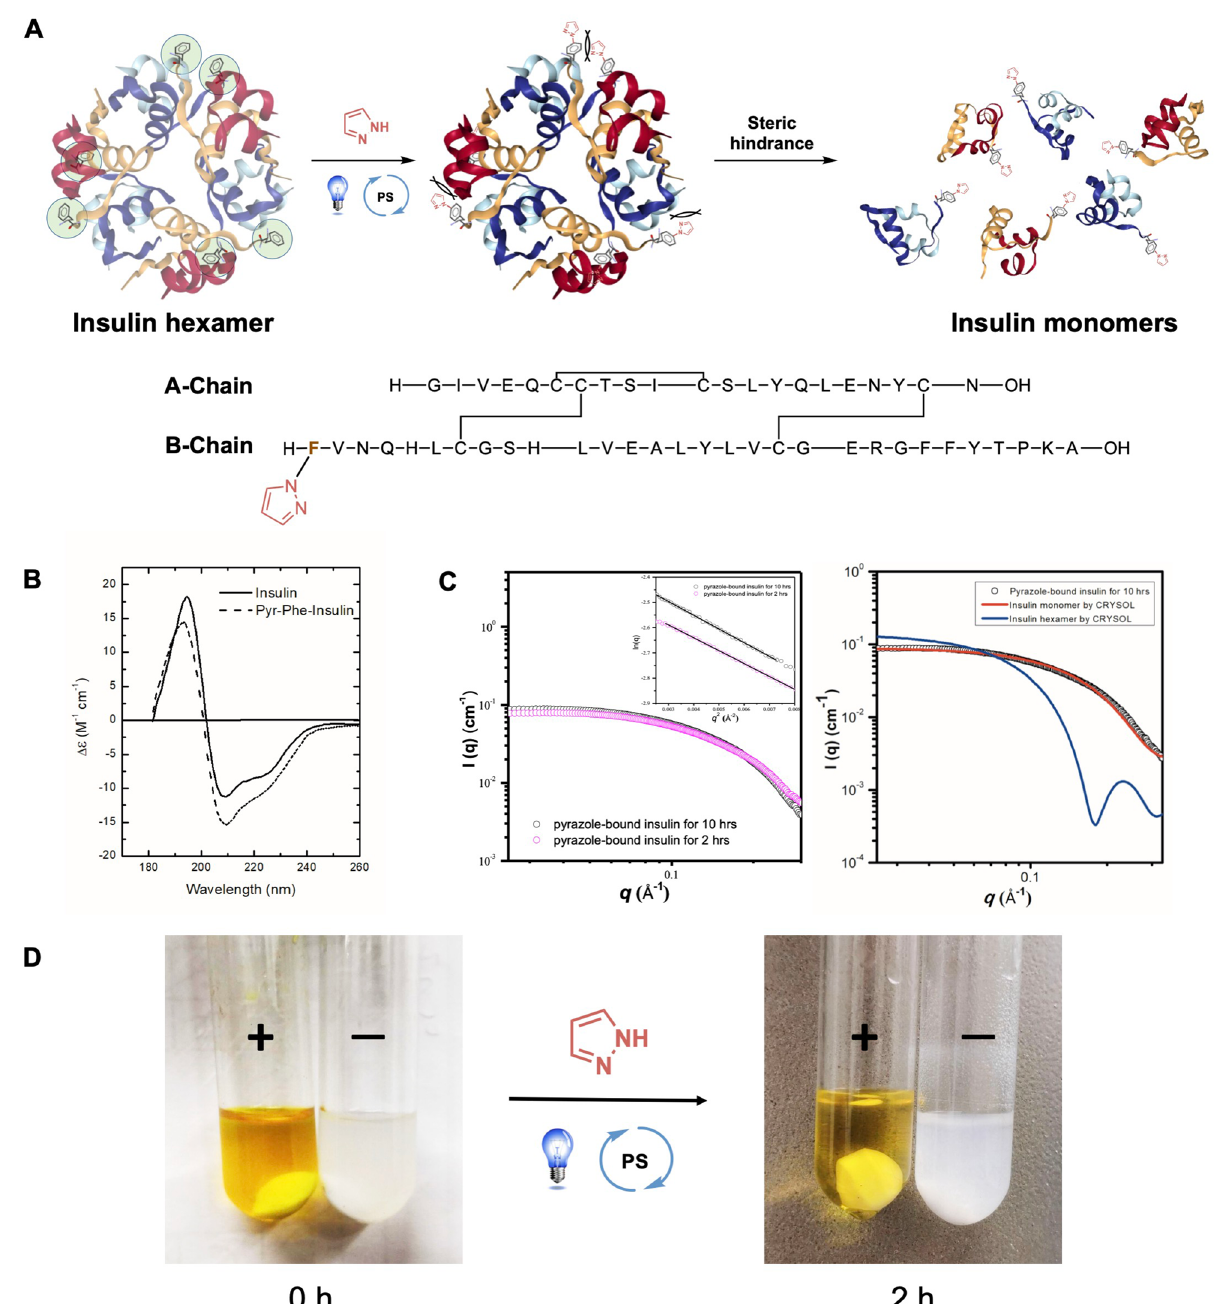
Figure 4. Visible-light-induced pyrazole tagging for the synthesis of phenylalanine-targeted insulin conjugates and its activity. ( A ) Site-selective visible-light-induced pyrazole tagging strategy. Crystal structure of Insulin (PDB: 4ins) with six native phenylalanine residues shown as green circles. ( B ) Near-UV circular dichroism of insulin (—) and Pyr-tagged insulin (–). For circular dichroism studies, all samples were measured at identical protein concentrations using the same 100-μm-pathlength cuvette. ( C ) Left: Representative SAXS data obtained for pyrazole-tagged insulin as a function of reaction time. Inset shows the Guinier curve-fitted lines for Rg values to the experimental data; Right: The small angle X-ray scattering studied of VPT conjugated insulin (black circle). The data is fitted using the program CRYSOL (solid curves). The solid lines represent the theoretical curves calculated from the crystal structures of the insulin monomer (PDB: 2jv1, red line) and the insulin hexamer (PDB: 1ai, blue line) ( D ) Insulin, when formulated with pyrazole conjugates, shows soluble after the reaction of 2 h, whereas it readily precipitates from solution when dissolved alone. Shown is an illustrative example of this effect following pyrazole-tagged insulin (+) compared with insulin alone in solution